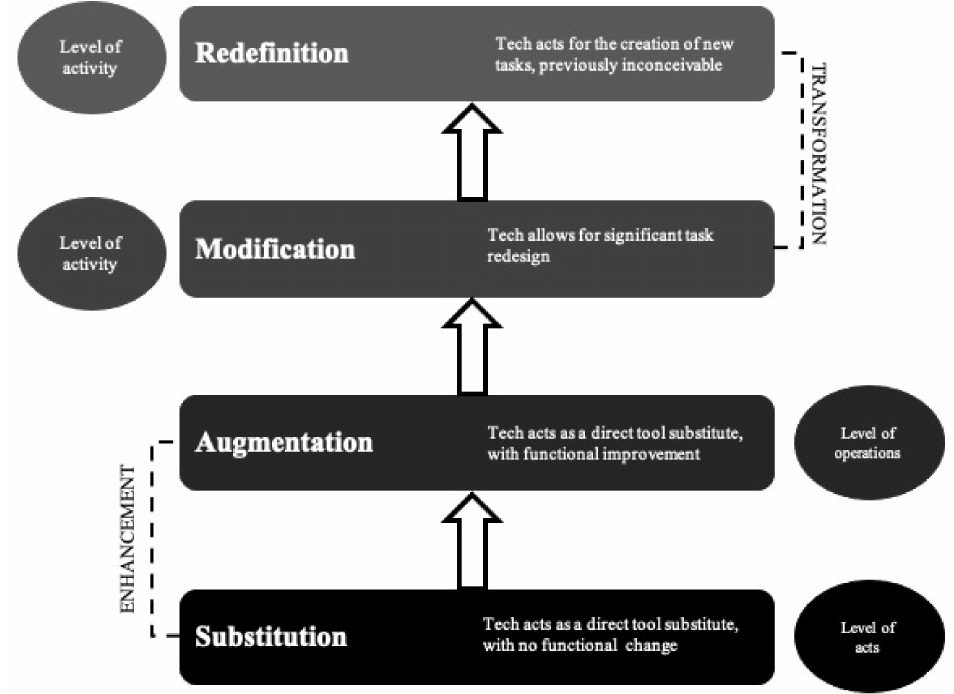
Figure 4. The SAMR model: a taxonomy of AI technology and impact on social